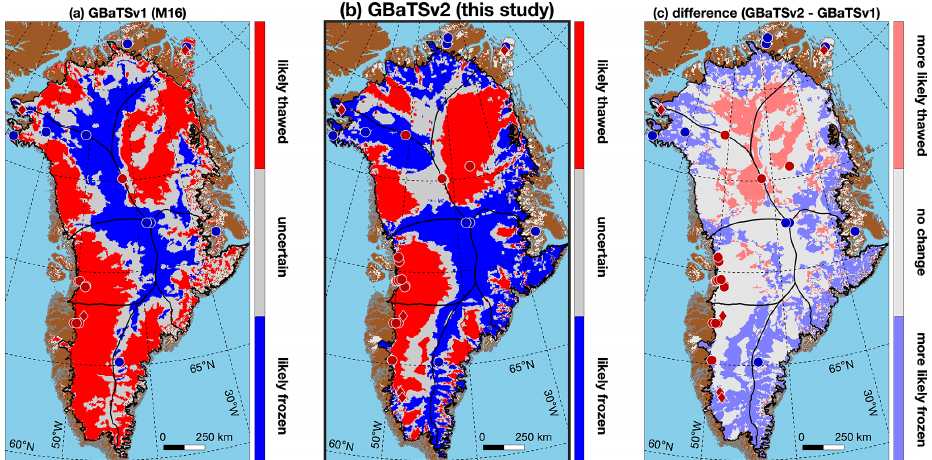
Figure 8. (a) Previous (GBaTSv1) and (b) new (GBaTSv2) likely basal thermal state of the GrIS ( L) , based on where the standard, cold-bias and warm-bias estimates of this state agree (Fig. 7b–d; Sect. 2.7). Note that (a) shows the borehole states and subglacial lakes as reported by M16. (c) Difference between GBaTSv2 and GBaTSv1.